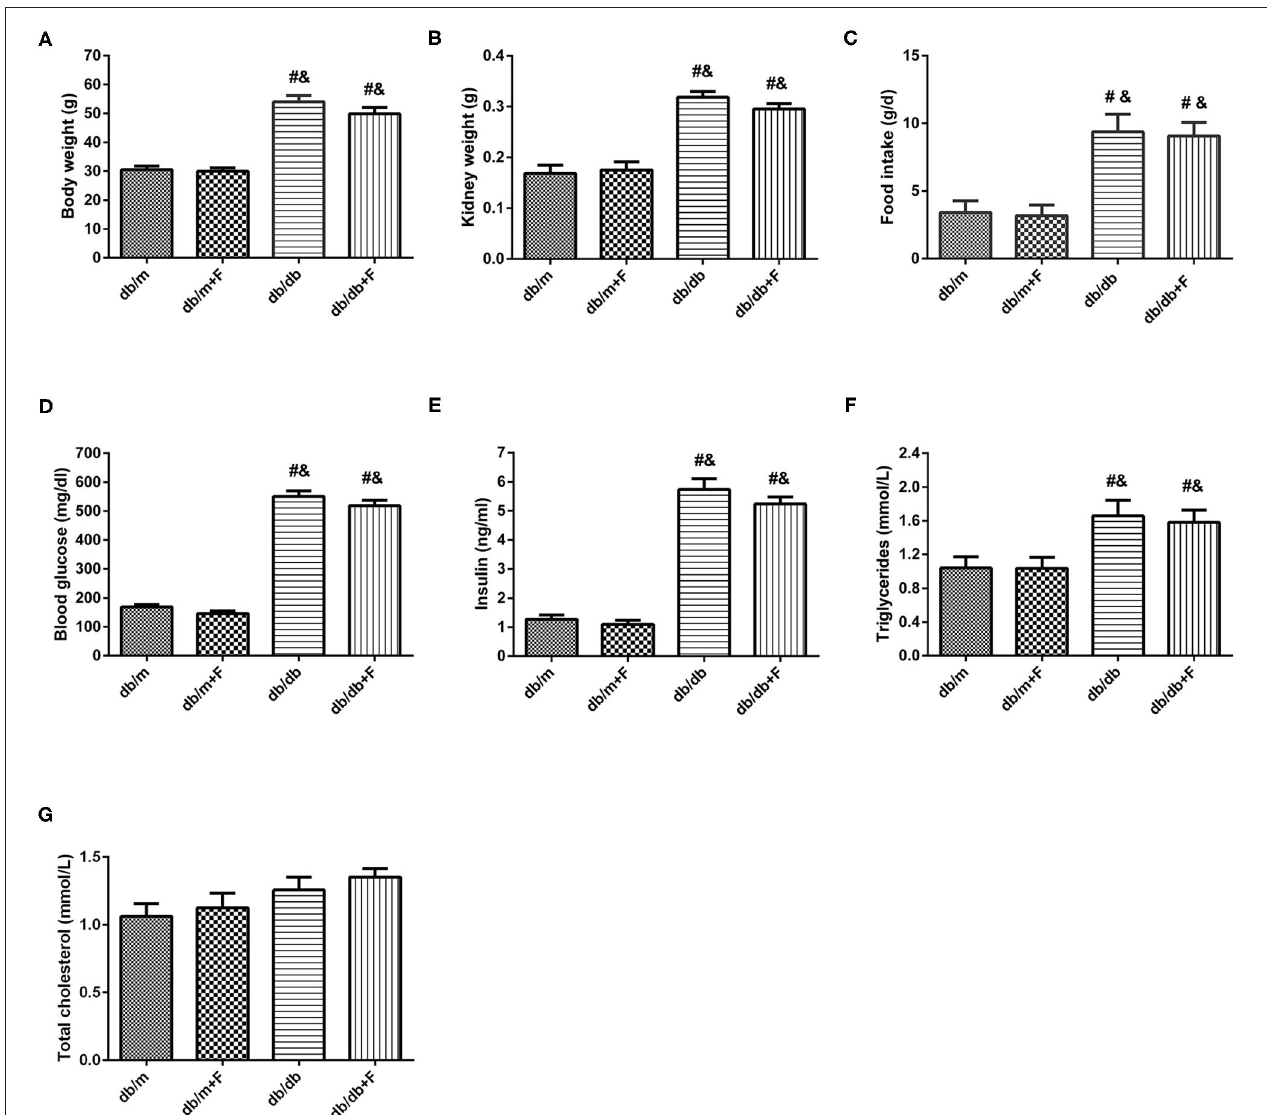
FIGURE 1 | Physical and biochemical characteristics in db/m, db/m + F, db/db, and db/db + F groups. (A) Body weight. (B) Kidney weight. (C) Food intake. (D) Fasting blood glucose level. (E) Fasting Insulin level. (F) Fasting triglycerides. (G) Fasting total cholesterol. n = 6 mice/group. # P < 0.05, vs. db/m group; & P < 0.05 vs. db/m + F group. Db/m, db/m mice without fenofibrate treatment; db/m + F, db/m mice with fenofibrate treatment; db/db, db/db mice without fenofibrate treatment; db/db + F, db/db mice with fenofibrate treatment. Data are means ± S.E.M.